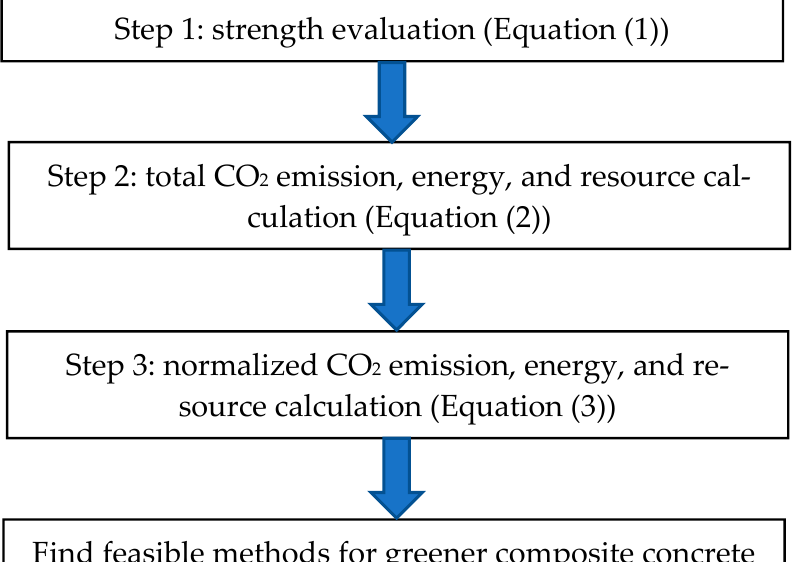
Figure 5. Flowchart of sustainability analysis. Figure 6 shows the results of sustainability for the water/binder ratio 0.65 group. From 28 to 90 days, the strength of concrete increased (Figure 6a,b). Figure 6c,d shows that as the replacement percentage of metakaolin increases, the normalized CO 2 emissions and resource consumption decreased. Moreover, as the design age changed from 28 to 90 days, the normalized CO 2 emissions and resource consumption decreased. Figure 6e shows the normalized energy consumption. When the replacement ratio of metakaolin was less than 0.15, normalized energy consumption showed reductions as the content of metakaolin increased. Once the replacement ratio of metakaolin was higher than 0.15, normalized energy consumption showed slight increments as the content of metakaolin than that of the rest of a concrete mixture. Moreover, as shown in the Table 1, as the content of metakaolin increased, the content of superplasticizer significantly increased. Figure 6f shows the effect of superplasticizer on normalized energy consumption. The